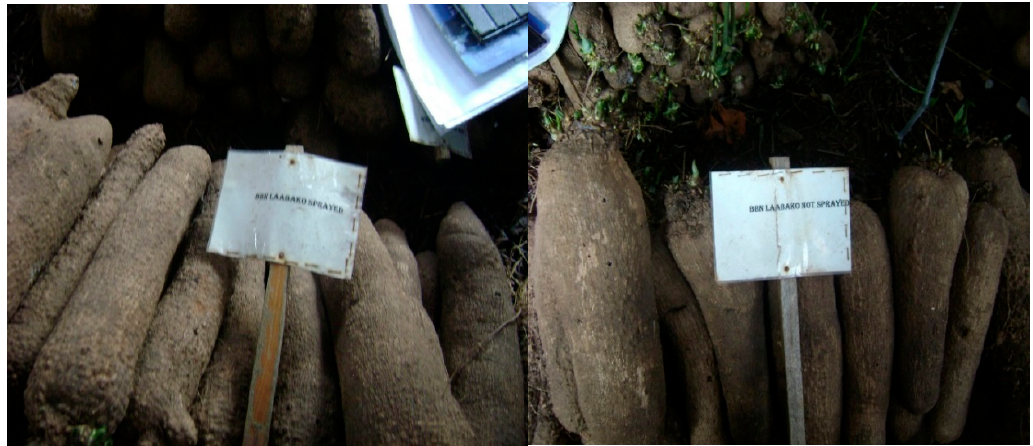
Figure 4. Yam tubers in storage with their labels.